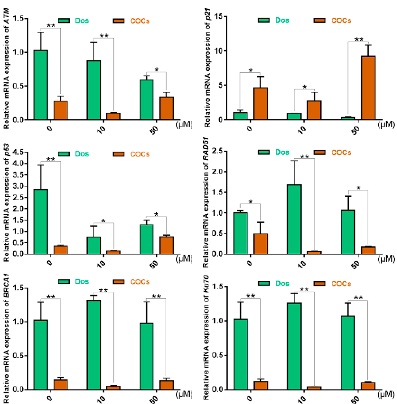
Figure 5. Relative mRNA expression levels of genes in oocytes by qRT-PCR after bovine denuded oocytes (Dos) and COCs treated with different concentrations of Zeocin (10 μ M and 50 μ M) for 2 h. * indicates p < 0.05, ** indicates p < 0.01.